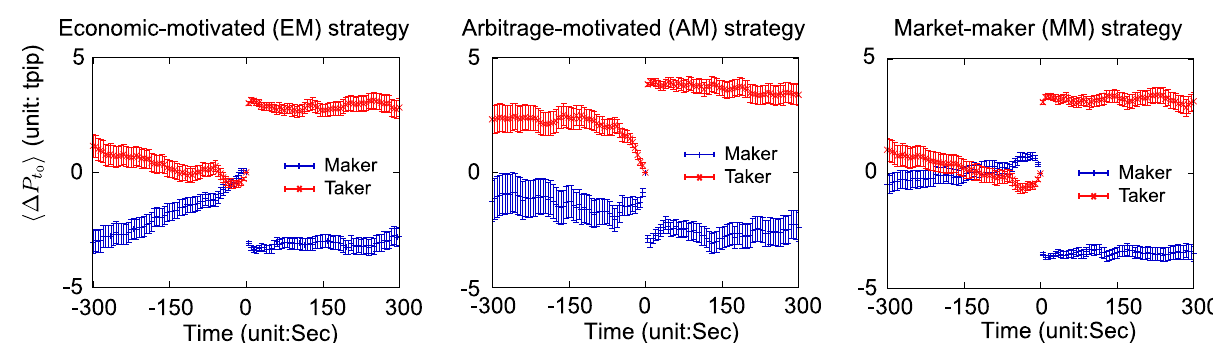
Fig 8. Average price changes around the transaction timing (Time 0) of the EM, AM, and MM strategies as a taker and a maker. Error bars represent the standard errors, and h�i represents the ensemble average. Banks employing the EM strategy are likely to transact as a maker during gradual price appreciation, while banks employing the AM strategy are likely to transact as a taker under rapid price depreciation. No strategy characteristic is evident for the MM strategy. In each case, the average price changes after the transactions plateau, which implies that none of the strategies has strategic superiority on